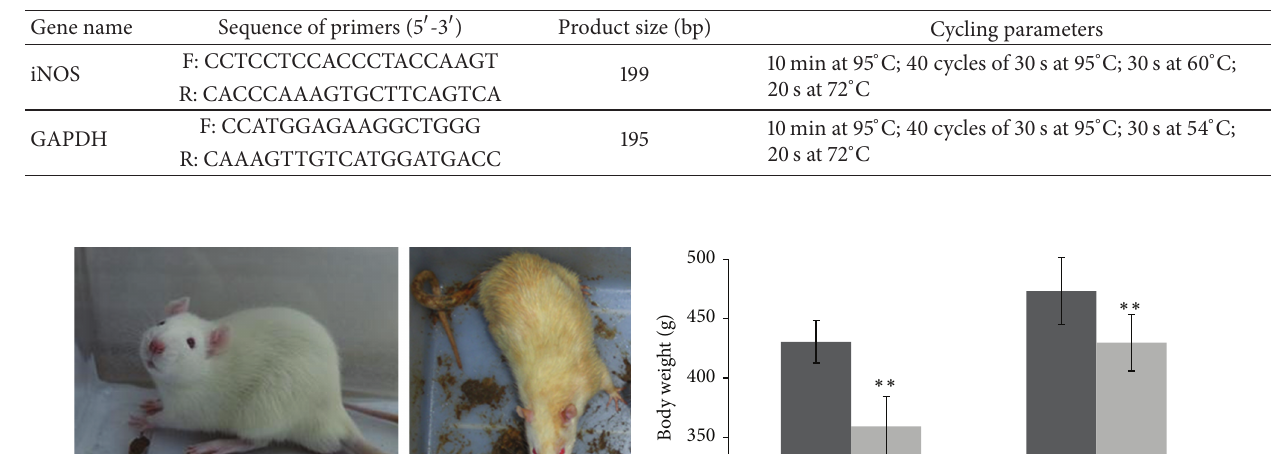
Table 1: The sequences of the RT-PCR primers and cycling parameters.